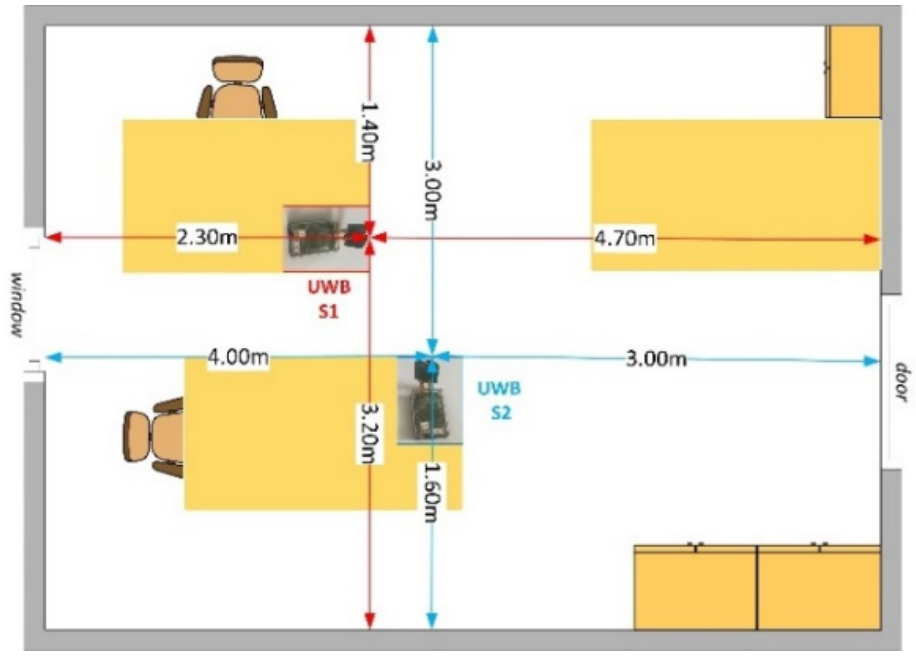
Figure 4. The room placement [32].